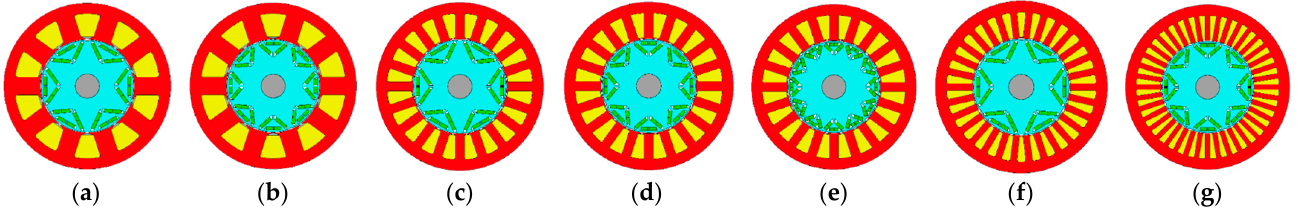
( c ) Figure 3. Inductance characteristics in different slot/pole combinations: ( a ) base speed condition, ( b ) high-speed condition, and ( c ) overload speed condition. ( a ) ( b ) ( c ) Figure 4. Torque characteristics in different slot/pole combinations: ( a ) base speed condition, ( b ) high-speed condition, and ( c ) overload speed condition. Through the comparative analysis, it is found that when the pole pair number is the same, the difference in value between the L d and L q becomes larger as the slot number increases, and the torque performance under high-speed conditions is better at the same time; when the slot number is the same, the torque performance under high-speed condi- tion becomes worse as the pole pair number increases. Compared with the integer slot winding, the fractional slot has a smaller torque ripple. It can be concluded that a motor that adopts a fractional slot can obtain better torque performance with a low torque ripple. Compared with the concentrated winding, the distributed winding has a larger difference